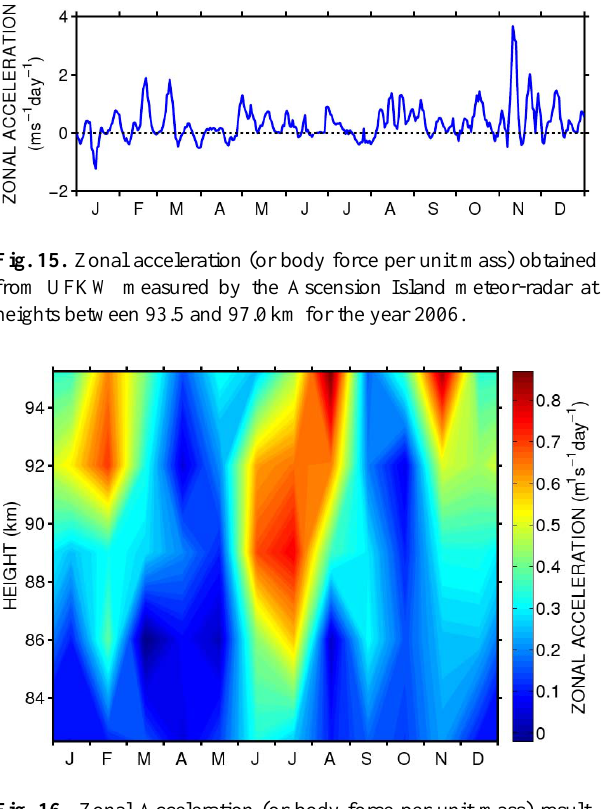
Fig. 16. Zonal Acceleration (or body force per unit mass) result- ing from UFKW with periods between 2.5–4.5 days, measured by the Ascension Island radar for the composite year of data available between